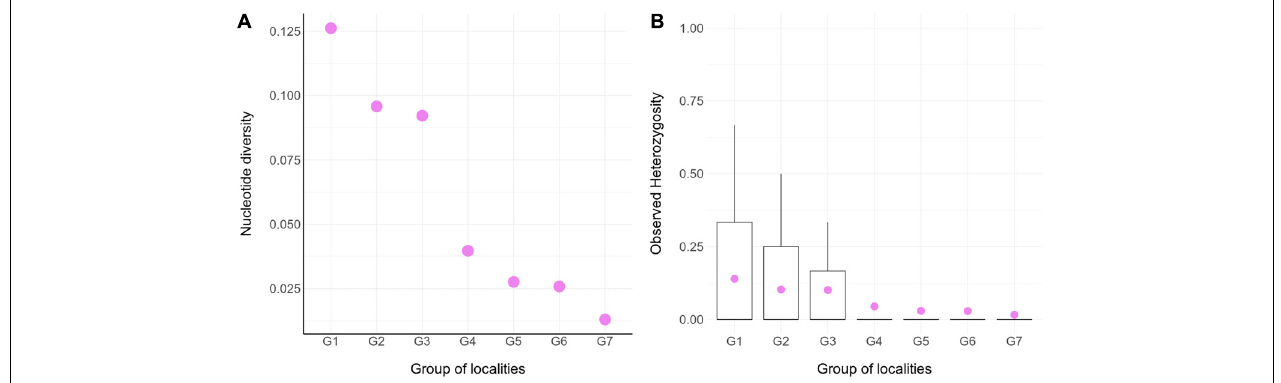
FIGURE 2 | Molecular diversity for seven groups of populations of Abrothrix hirta. (A) Molecular diversity index (Pi) calculated for seven groups of localities (G1- G7; Figure 1 ; Table 1 ). The values for this graph are given in Supplementary Table 1 . (B) Observed heterozygosity across individuals within groups. The data for this graph is given in Supplementary Table 2 .